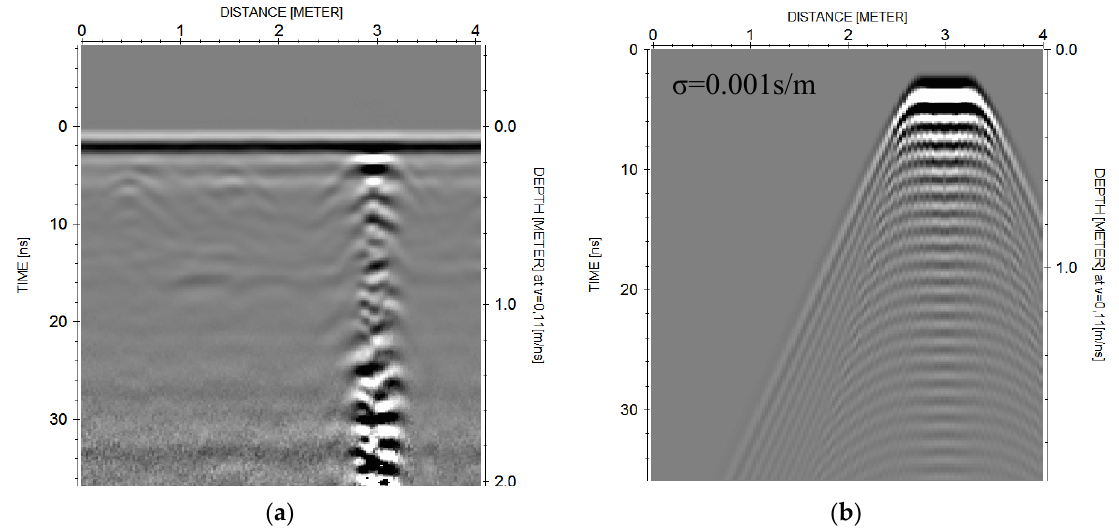
Figure 7. ( a ) Result obtained by GPR, and ( b ) result obtained by simulation.